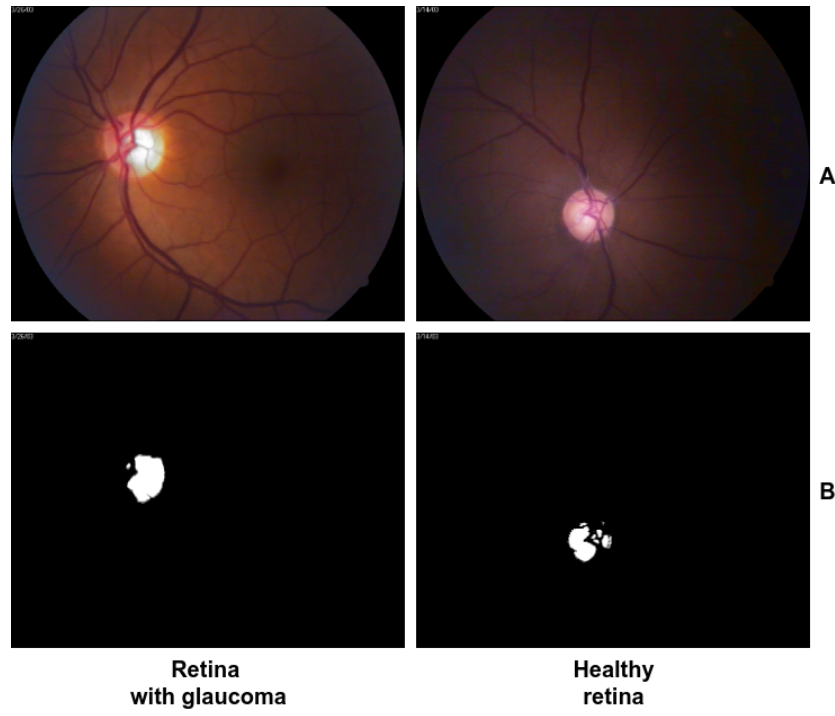
Figure 3. Results of images thresholding, ( A ) RGB images, ( B ) Binary